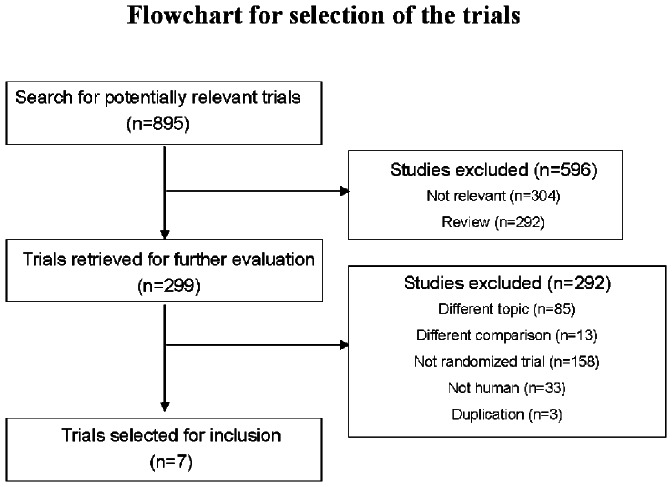
Flowchart of the selection of studies.